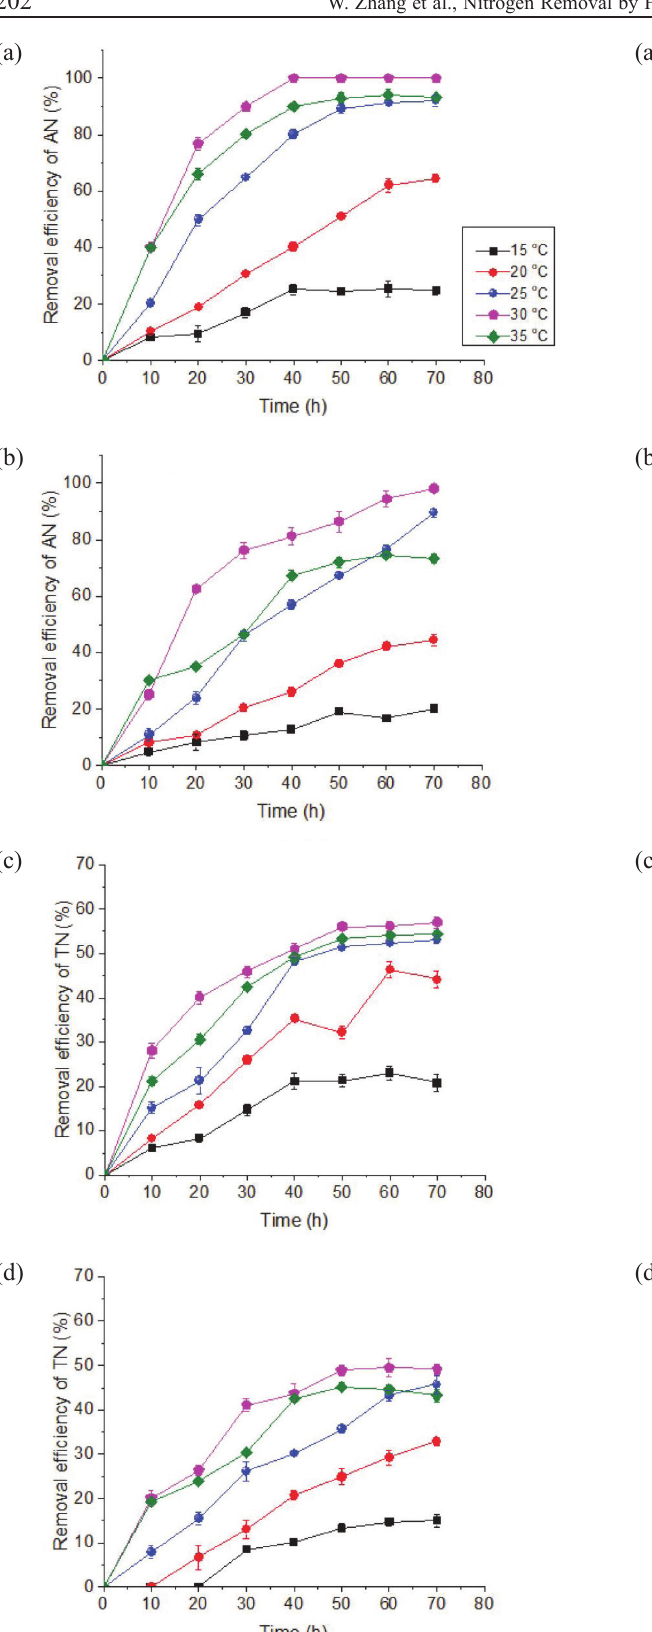
Fig. 6 – Effect of DO on AN removal by immobilized micro- organism (a) and free microorganism (b) and effect of DO on TN removal by immobilized microorganism (c) and free micro- organism